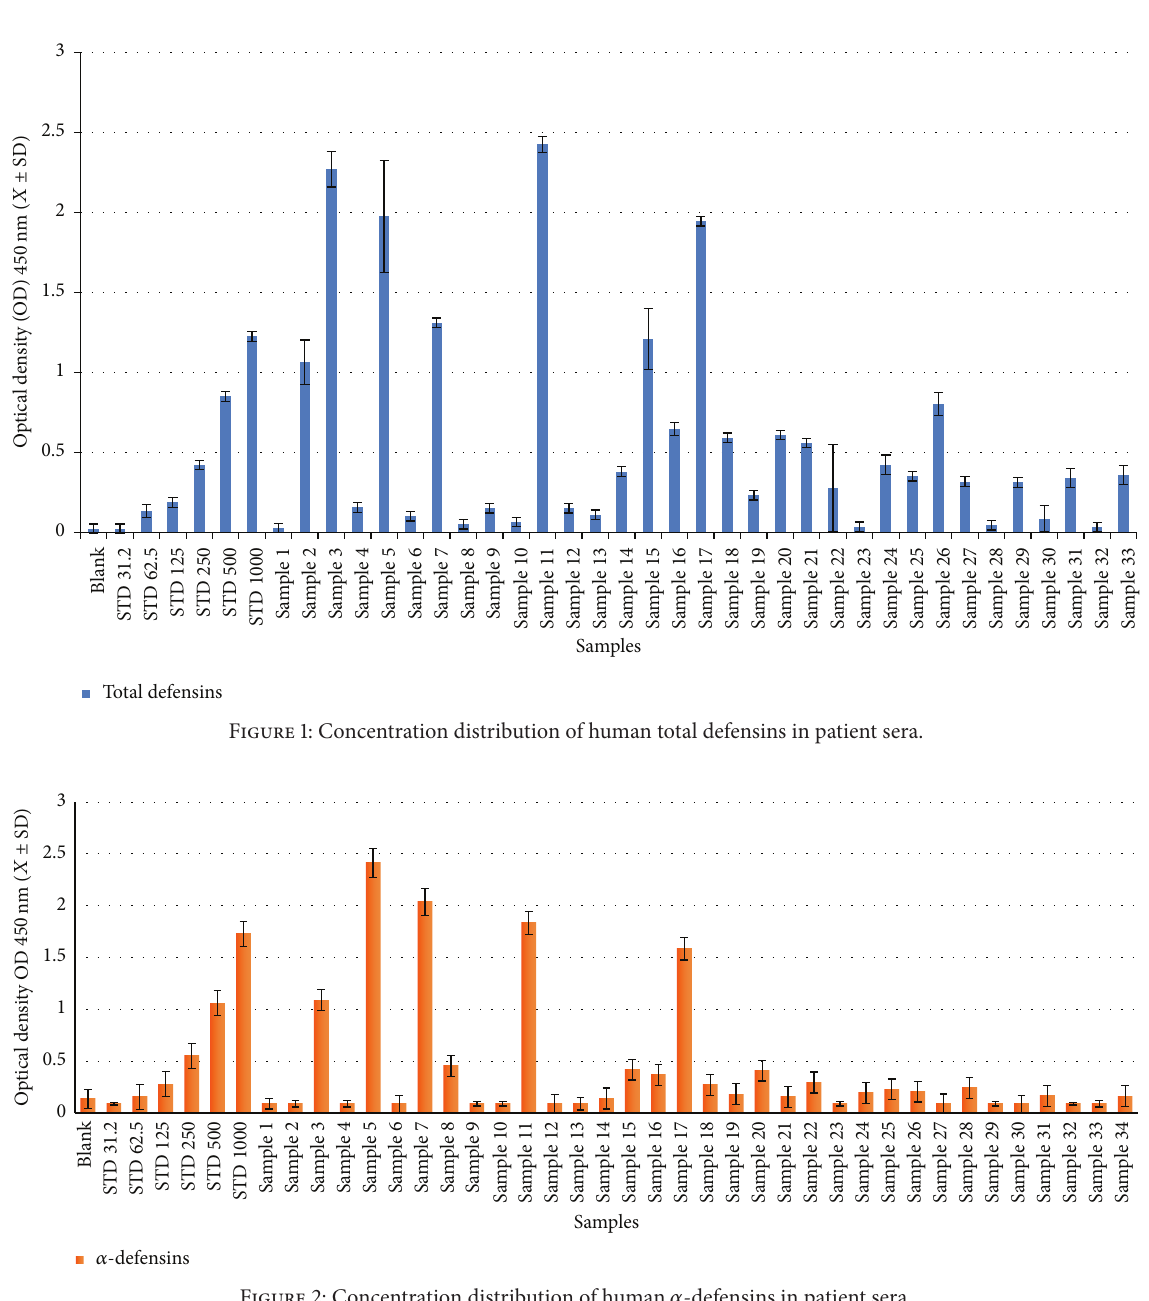
Figure 2: Concentration distribution of human 𝛼 -defensins in patient